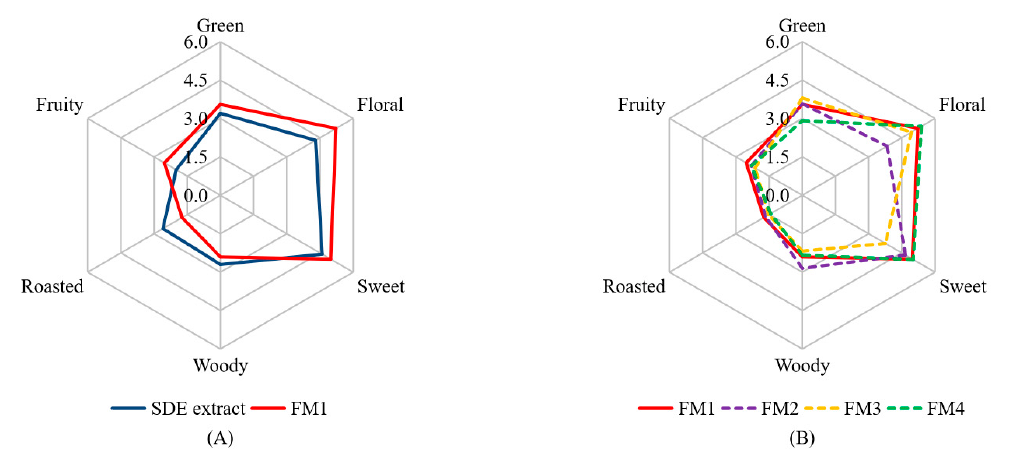
Figure 2. Aroma reconstruction ( A ) and aroma omission ( B ) based on GC-MS-O and OAV analyses of the SDE extract. FM1 was the aroma reconstruction model; FM2 was prepared by omitting 128.7 mg/L of linalool (floral) from FM1; FM3 was prepared by omitting 5.9 mg/L of trans- β -damascenone (sweet) from FM1; FM4 was prepared by omitting 42.1 mg/L of camphene (green) from FM1. In Figure 2A, SDE extracts and FM1 samples showed significant difference ( p < 0.05) in floral and roasted notes; in Figure 2B, FM1 and FM2 samples showed significant difference ( p < 0.05) in floral note, FM1 and FM3 samples showed significant difference ( p < 0.05) in sweet note, FM1 and FM4 samples showed significant difference ( p < 0.05) in green note.